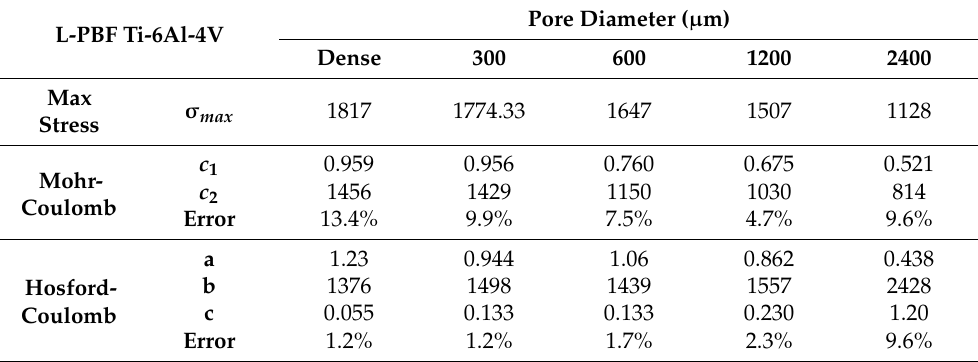
Table 2. Calibrated stress-based fracture model parameters for Ti-6Al-4V using data from dense pure shear and equibiaxial tension tests combined with dense, 300 µ m, 600 µ m, 1200 µ m, and 2400 µ m pore round notched tension tests. Error is the mean absolute percentage error for the model predicted values of equivalent stress on the fracture surface compared to the experimental values of equivalent stress across each stress state used in